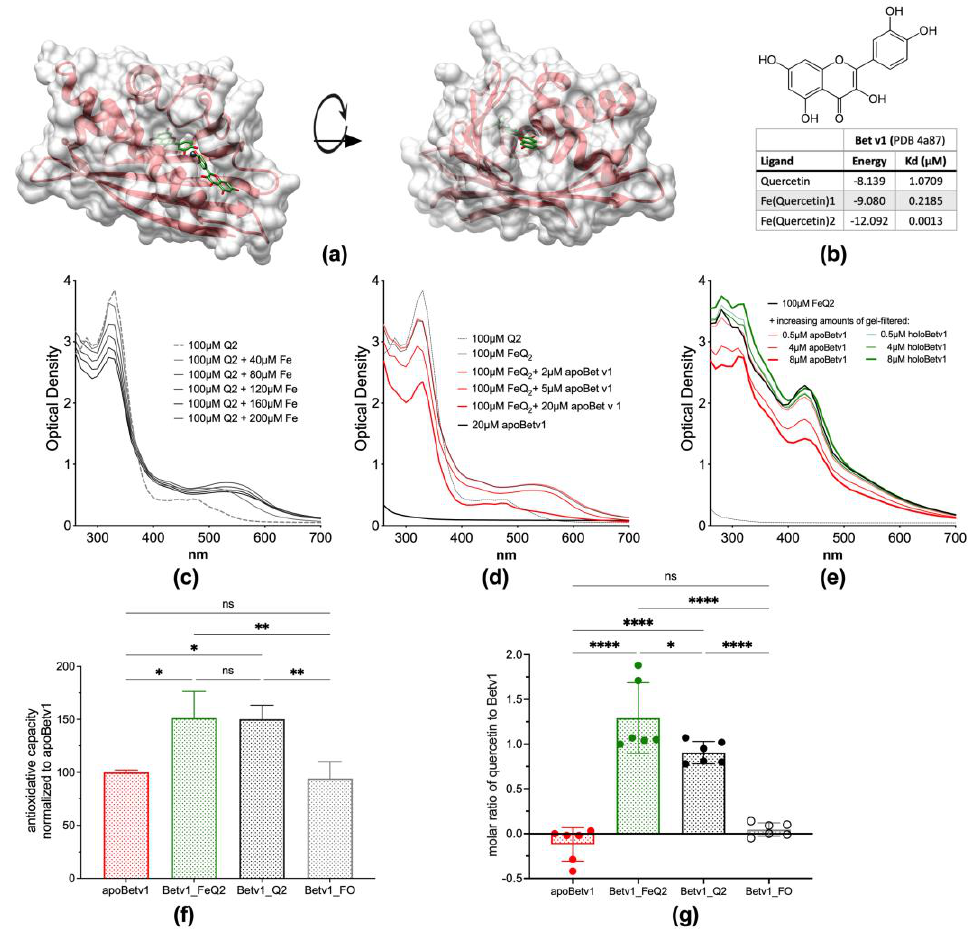
Figure 1. Bet v 1 binds iron—quercetin complexes ( a ): Protein surface of the major birch pollen allergen Bet v 1, incorporating iron(quercetin) 2 (FeQ 2 ) (sticks with carbons in green, oxygens in red, and iron shown as a grey sphere) ( b ): Molecular structure of quercetin and calculated affinities of quercetin in conjunction with iron to Bet v 1. ( c ): Optical spectra of 200 µ M quercetin (=100 µ M Q2) with increasing concentration of ferric iron at pH 7.3. ( d ): Optical spectra of 20 µ M Bet v1, 100 µ M Q2 or FeQ2 alone, or by adding increasing concentrations of Bet v 1. ( e ): FeQ2 spectra with and without the addition of increasing doses of gel—filtrated purified apoBet v 1 or holoBet v 1. ( f ): ApoBet v 1 was preincubated with FeQ2, Q2 or ferroxamine (FO), before removing unbound ligands by gelfiltration and performing a Trolox Equivalent Antioxidative test using Trolox as reference. ( g ): Calculated amount of bound quercetin to Bet v 1 measuring the antioxidative capacity with quercetin and FeQ2 as reference. For statistical analyses ( f , g ) were compared with one-way ANOVA following Holm- Sidák’s multiple comparisons test with a single pooled variance; Mean ± SD; ns not significant, * p < 0.05, ** p < 0.01, **** p < 0.0001.